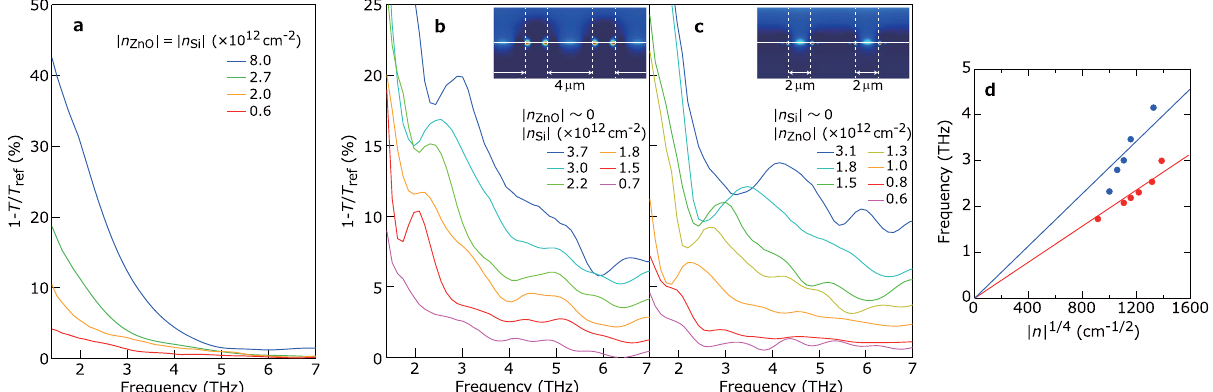
Fig. 3 Selective activation of plasmonic cavity. a Extinction spectra for uniform conditions (| n ZnO | = | n Si |) at several values of carrier density. b , c Extinction spectra for | n ZnO | ~ 0 (| n Si | ~ 0) for several values of | n Si | (| n ZnO |). Each trace is vertically offset by 1%. The insets show the simulated electric fi eld intensity at resonance frequencies for the carrier density of 3 : 0 ´ 10 12 cm (cid:2) 2 in the plasmon active regions. The horizontal solid and vertical dotted lines indicate the position of the graphene and boundaries, respectively. d Plasmon resonance frequency obtained from the spectra in b (red circles) and c (blue circles) as a function of | n | 1/4 . Red and blue lines represent calculated plasmon frequency in cavities with W = 4 and 2 μ m, respectively, based on Eq.